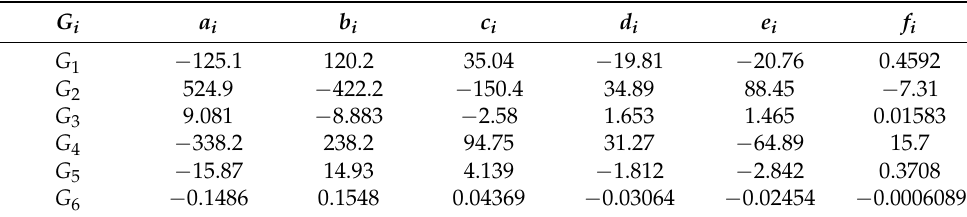
Table 9. Optimal value of the constants for the new design equation of safety